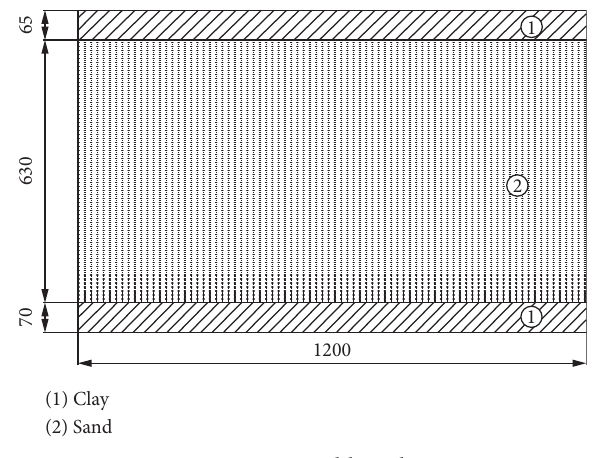
Figure 2: Design soil layer layout.